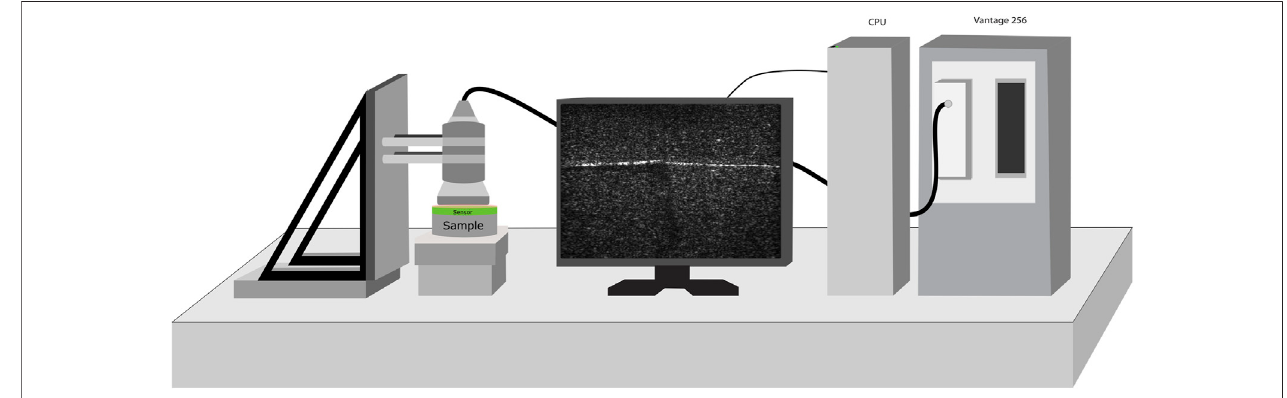
FIGURE1| Theexperimentalsetup,consistingofacustomprobemount,VerasonicsVantage256system,anda z -axisstage.Thetransducerisheld fi rmlyinplace as the z -axis stage is incrementally raised to compress the sample, during which shear wave and compression data is